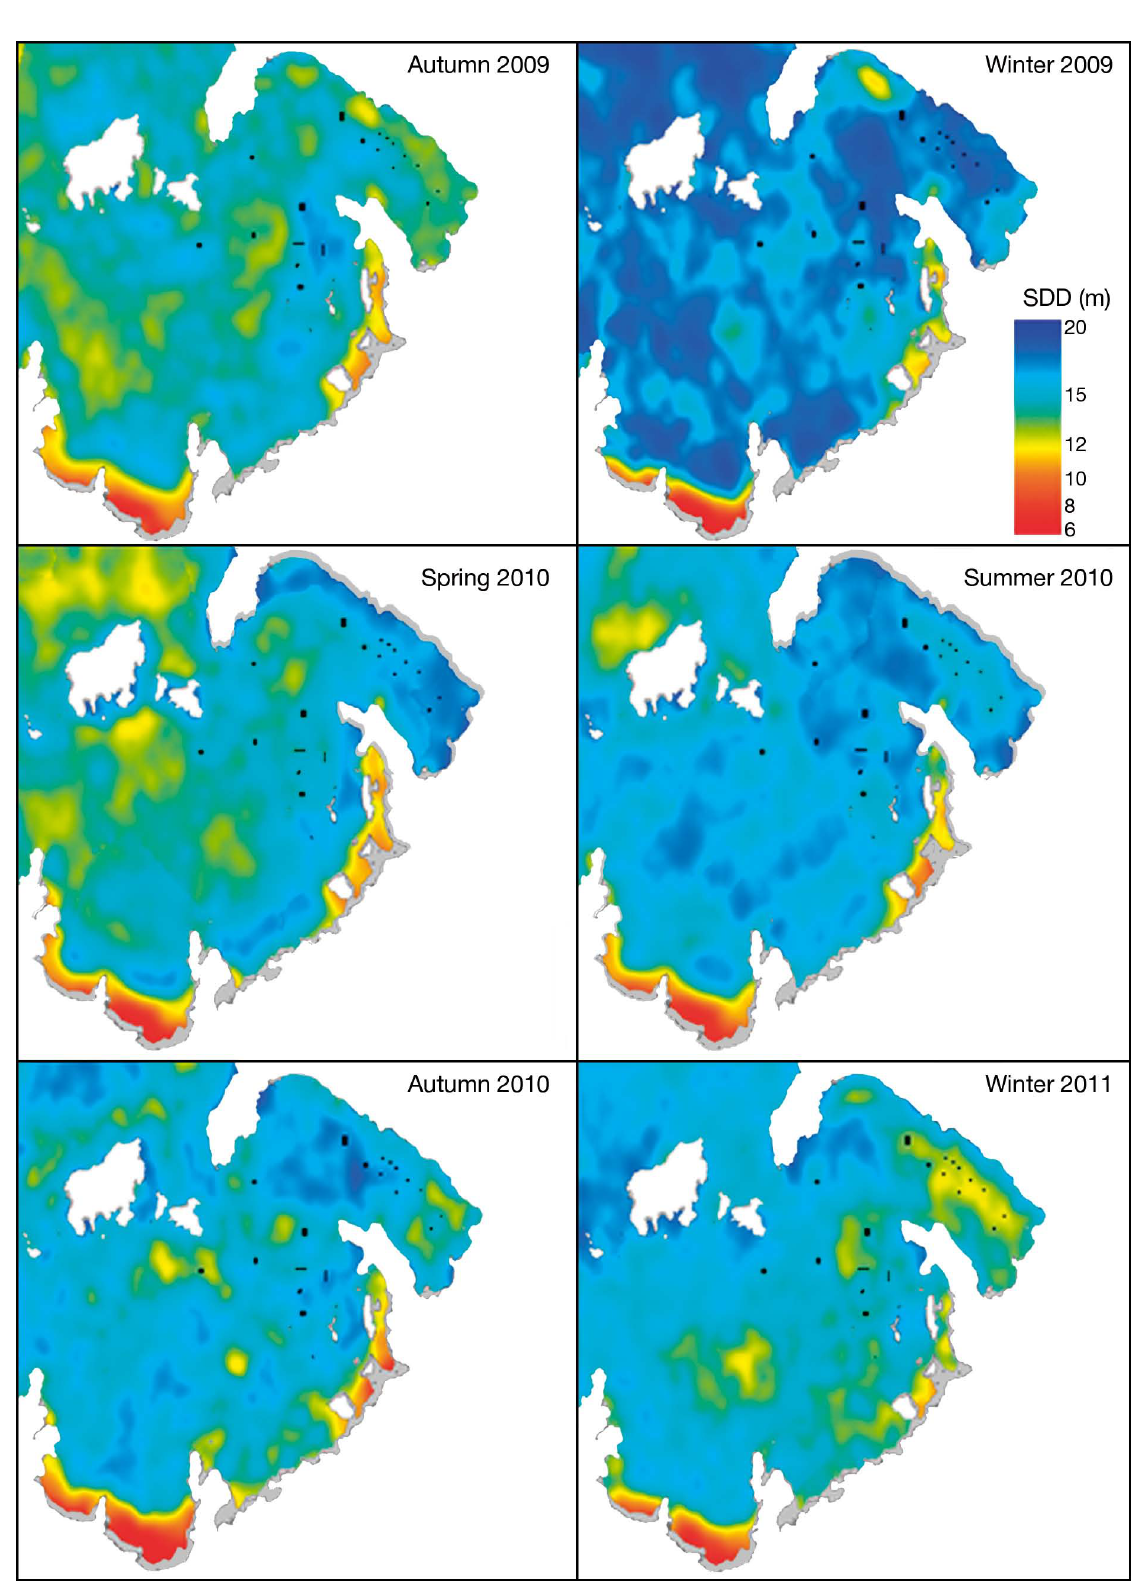
Fig. 5. Seasonal distribution of Secchi disk depths (SDD; black boxes show aquaculture areas, see Fig. 1) in Ildırı